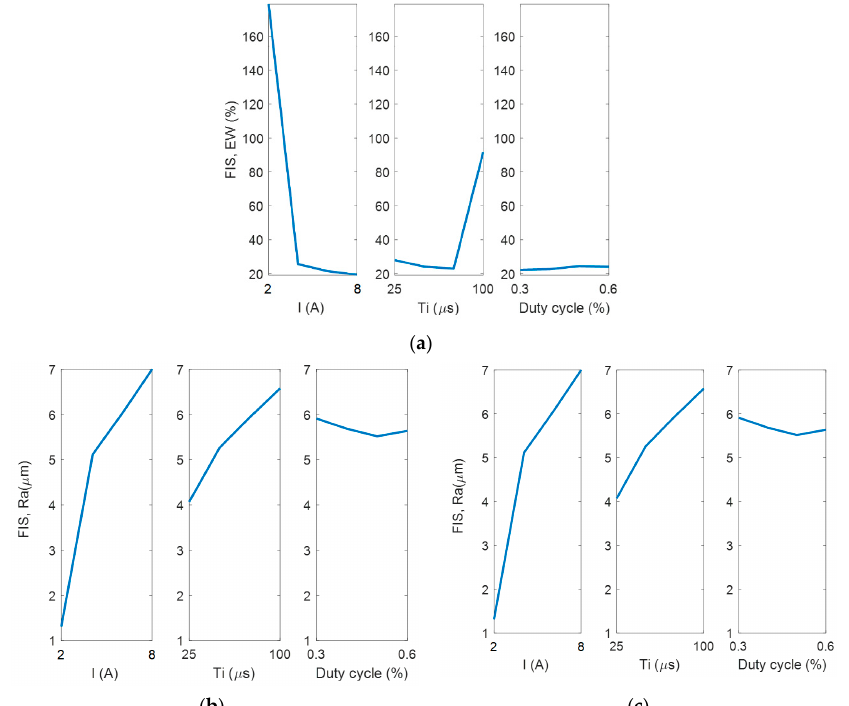
Figure 14. Main effects plot for ( a ) EW, ( b ) Ra, and ( c ) MRR in the case of negative polarity, obtained using the FIS.